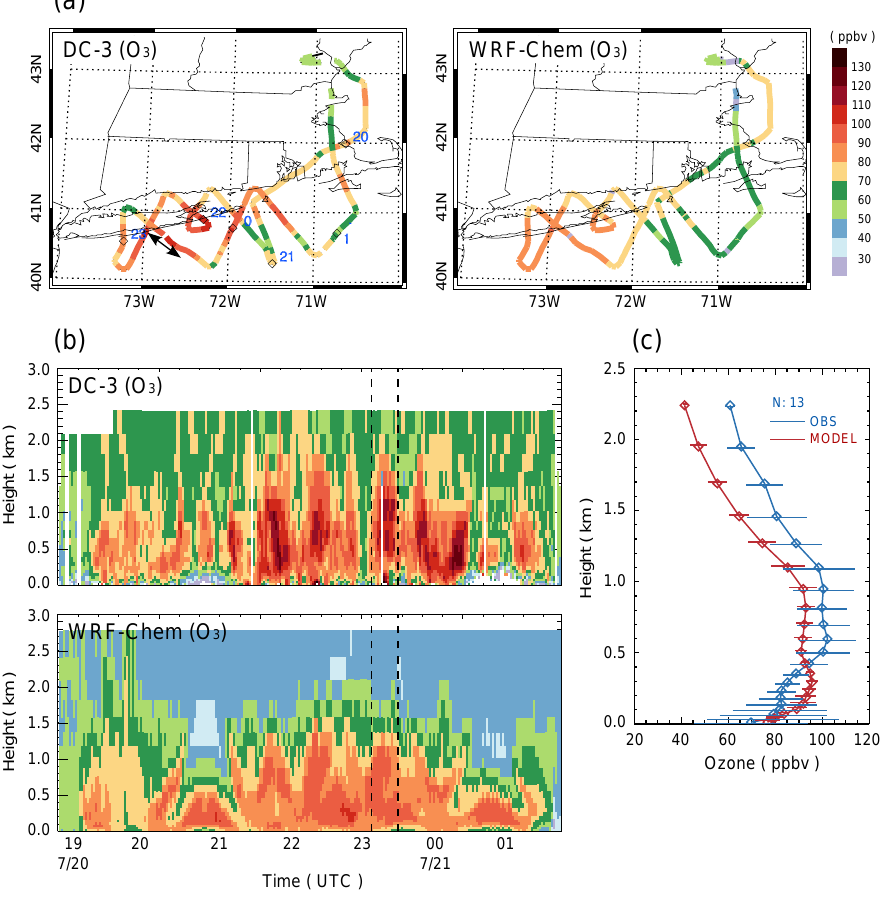
Fig. 7. (a) Horizontal distributions of observed and simulated O 3 mixing ratios measured from the DC-3 aircraft on 20 July. The ozone mixing ratios are vertically averaged from near surface to about 1.5km. (b) Vertical distributions of observed (top) and simulated (bottom) O 3 mixing ratios on 20 July as a function of time. (c) Mean profiles and standard deviations of observed and simulated O 3 mixing ratios in an ozone plume denoted by the double-headed arrow in (a) and dashed lines in (b) . N denotes the number of vertical